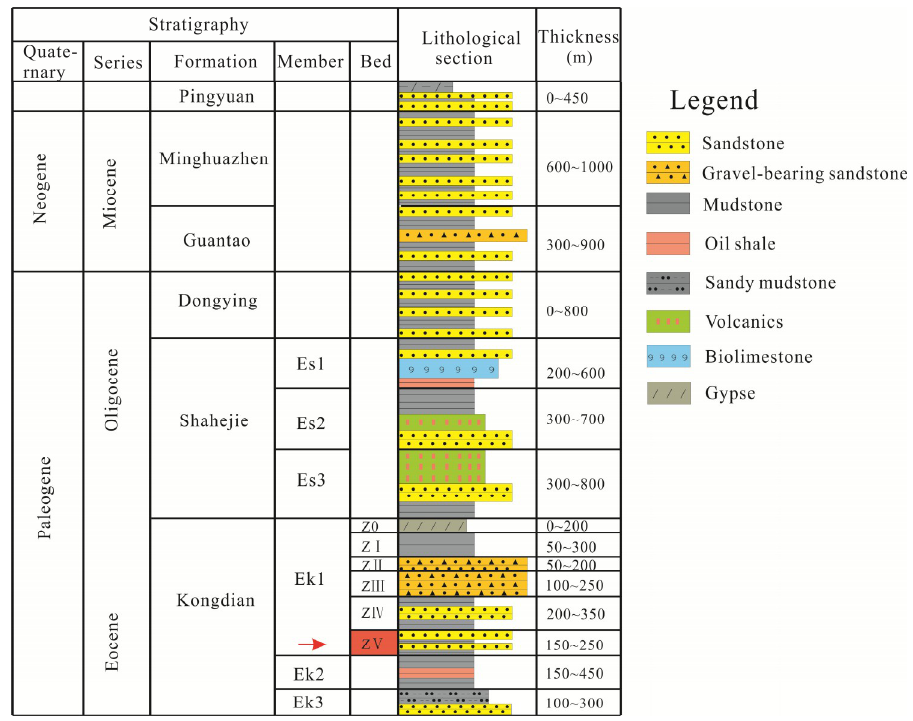
Figure 2. Stratigraphy, lithology, and thickness of Kongdian Formation in the study area (modified from Neng et al. [44]).